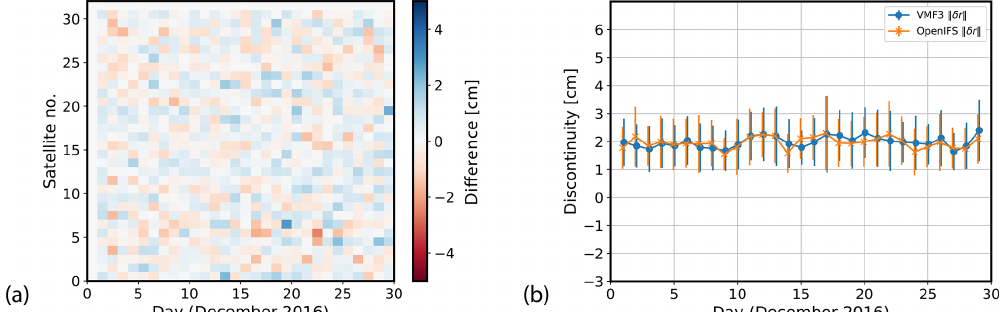
Figure 1. Norm of the midnight discontinuity ( (cid:107) δ r (cid:107) ) for December 2016. (a) A color map representing the difference between the default and experimental system for the satellites used in the experiment. (b) The mean (solid lines) and standard deviation (vertical whiskers) over all satellites for each day of the experiment with blue (default system) and orange (experimental